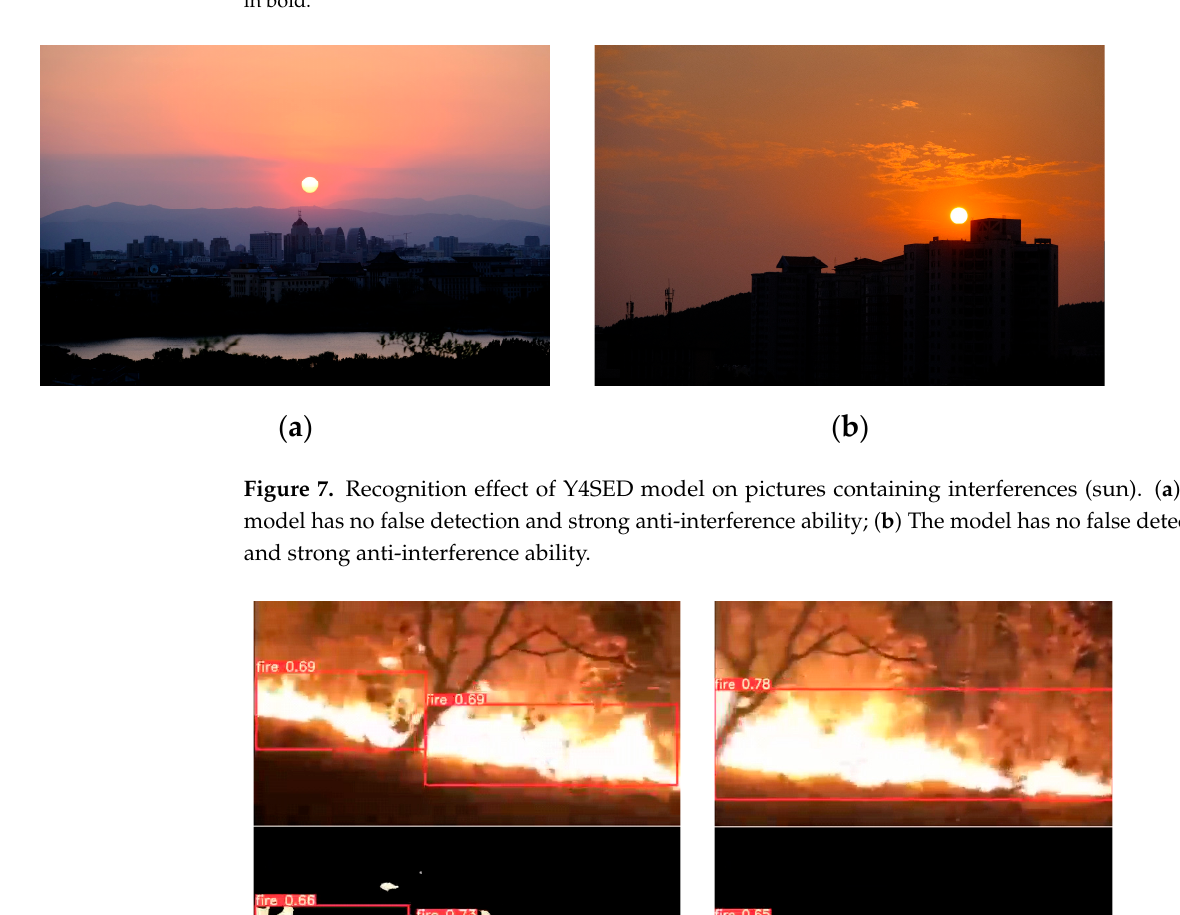
𝐴𝑅 (cid:3013) are all percentages. The best data for each indi-